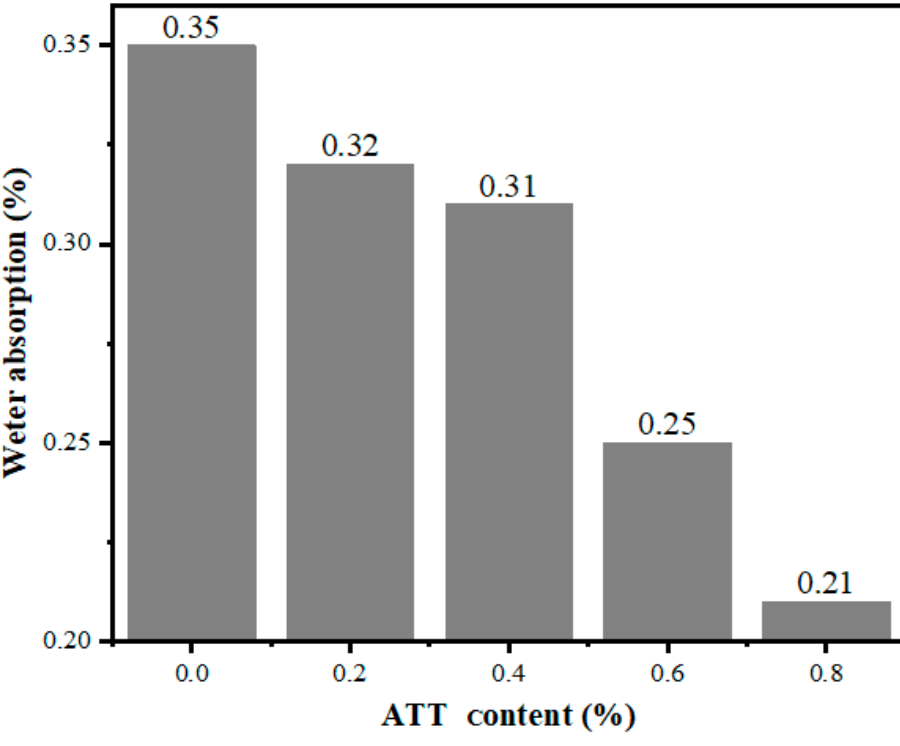
Figure 12. Water absorption data for MPP and ATT/MPP nanocomposites.